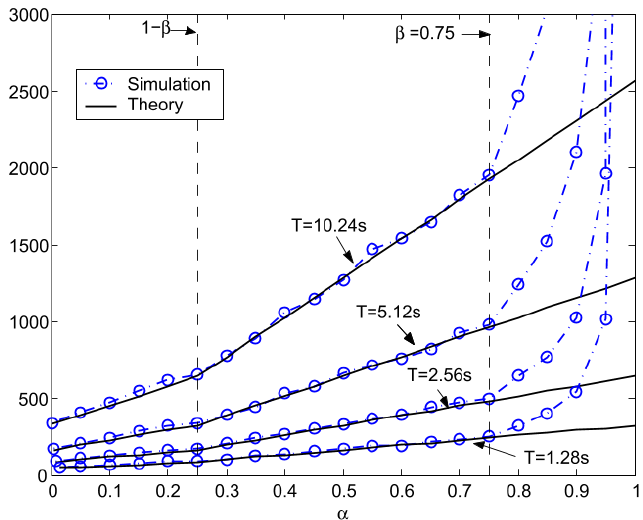
Figure 20. Average latency comparison with varied advertising duty ratio ( α ) and a fixed scanning duty ratio ( β = 0.75). Adapted from [79].